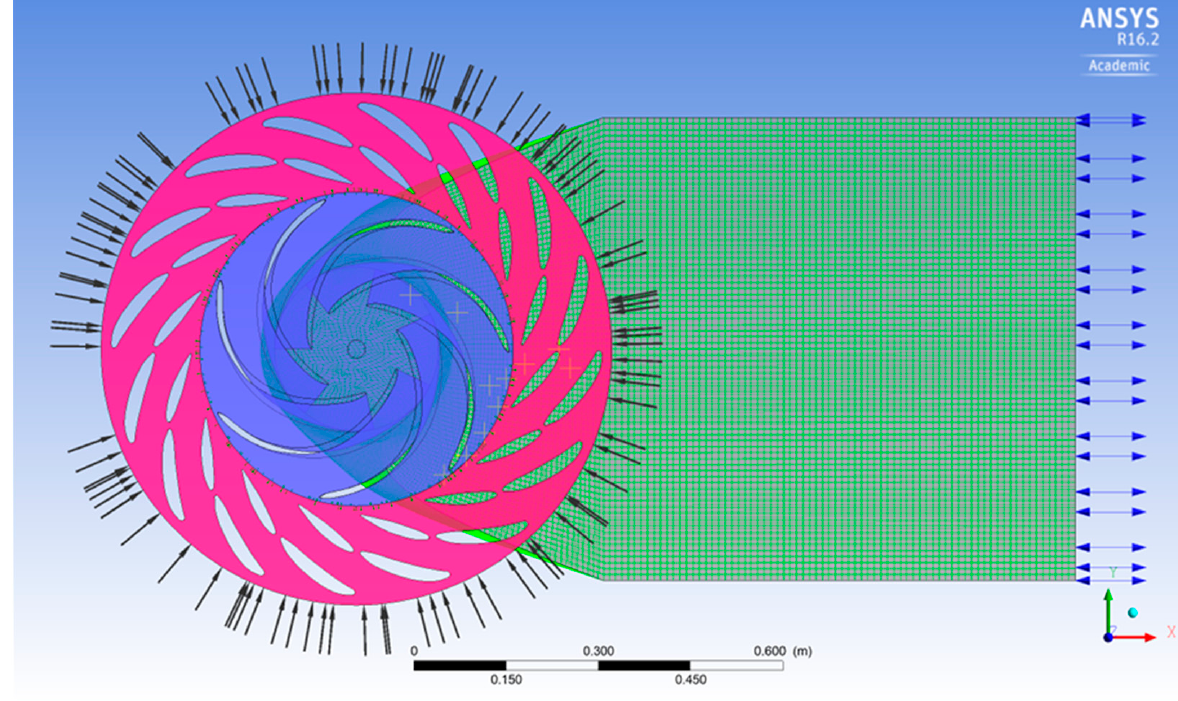
Figure 2. Top view of the computational domain for the case study.